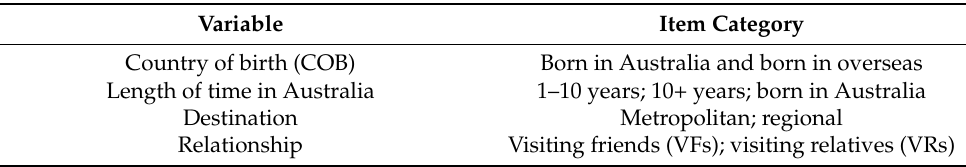
Table 2. Independent